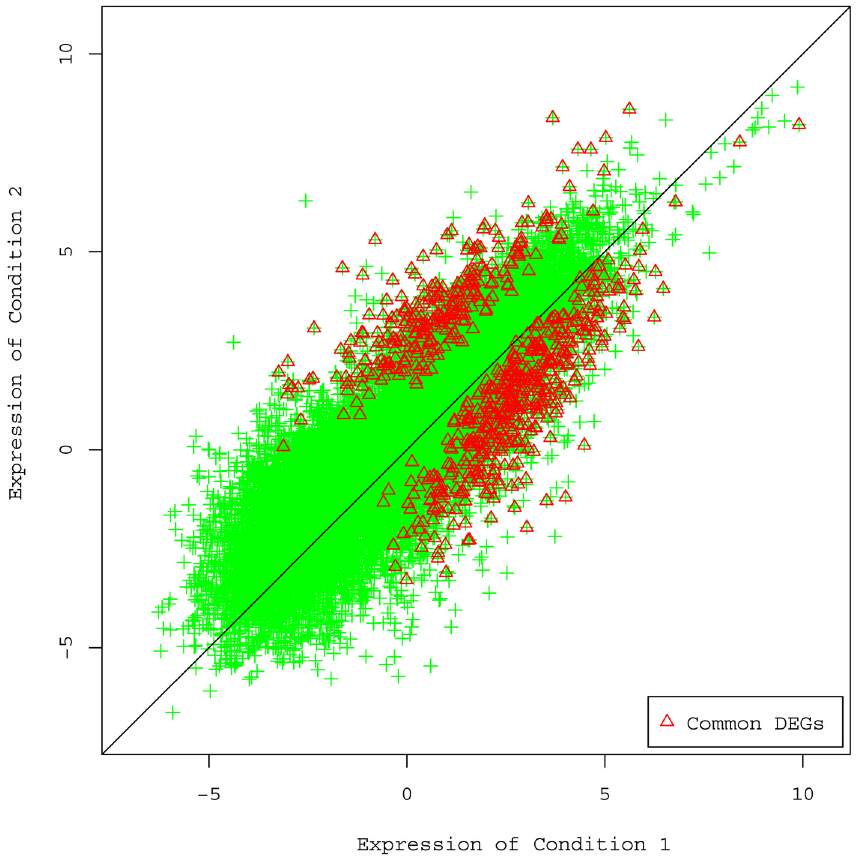
Fig 8. Scatter plot of the average logged RPKM estimation for the HDB dataset. There are 23,402 expressed genes (RPKM > 0 for both conditions), among which the 729 common DE genes found by all the four DE methods are represented by red triangles and others by green